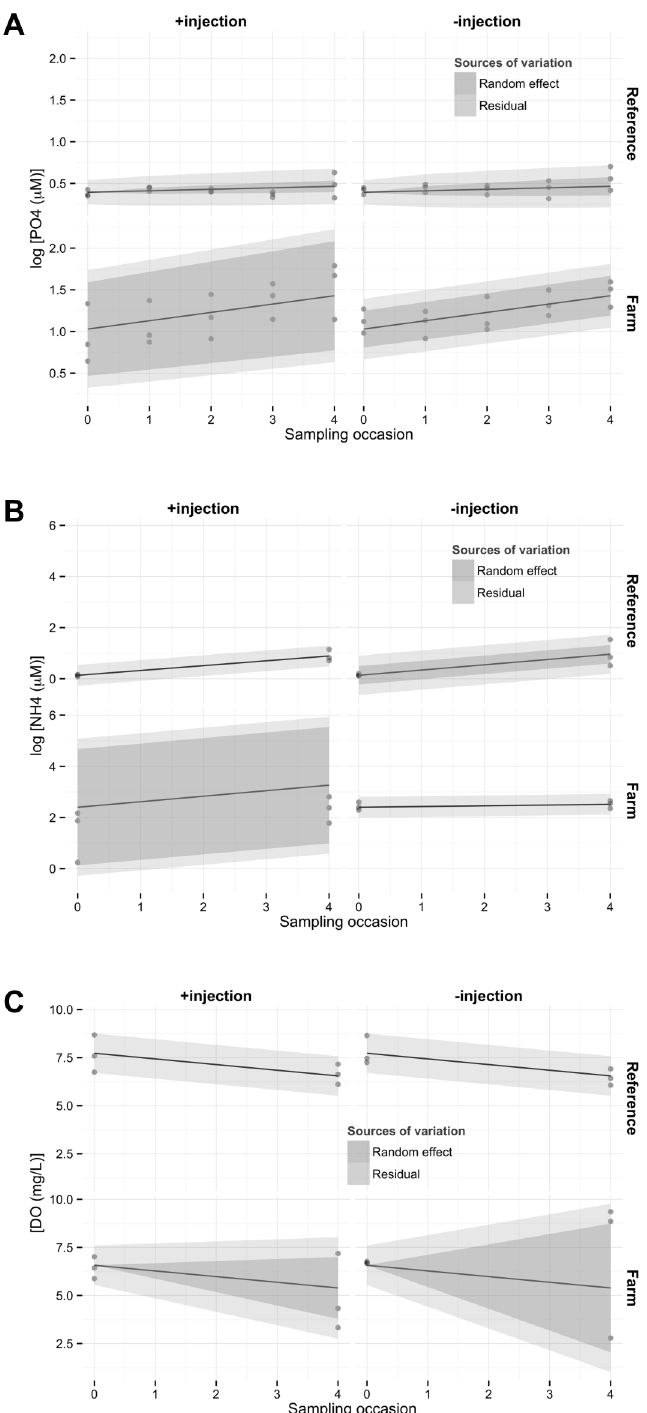
Fig 3. log PO 4 and B) log NH 4 as a function of sampling occasion (SamplN). A) Predictions from the selected models (regression lines) are reported on the figure. Areas represent 2 times the standard error due to random differences between blocks (Random effects, dark grey) or 2 times the residual errors (light grey).